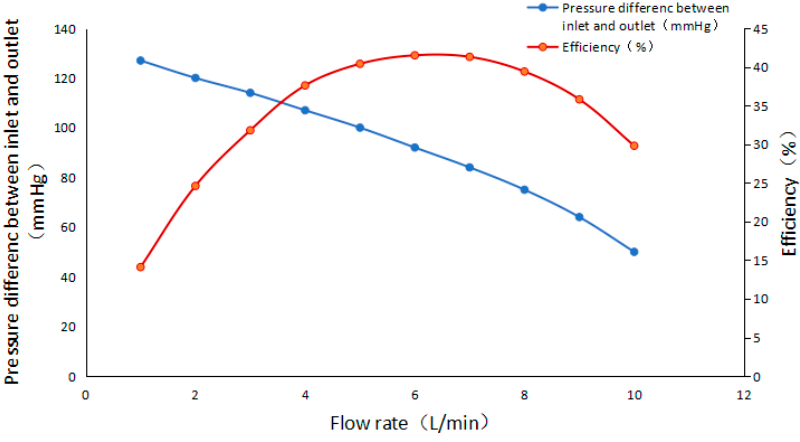
Figure 6. Performance characteristic of the centrifugal blood pump.